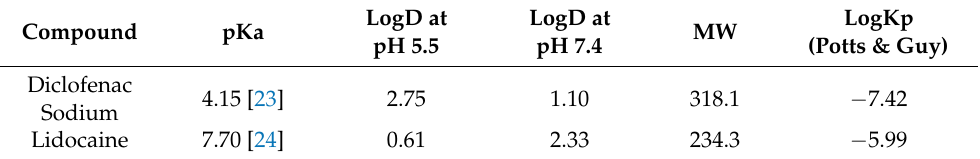
Table 3. Octanol-water distribution coefficients (log D), pKa values, and molecular weights (MWs) were obtained from the ChemAxon platform and log Kp in silico permeability (Potts and Guy). LogD at LogD at LogKp Compound pKa MW pH 5.5 pH 7.4 (Potts & Guy) Diclofenac 4.15 [23] 2.75 1.10 318.1 − 7.42 Sodium Lidocaine 7.70 [24] 0.61 2.33 234.3 −